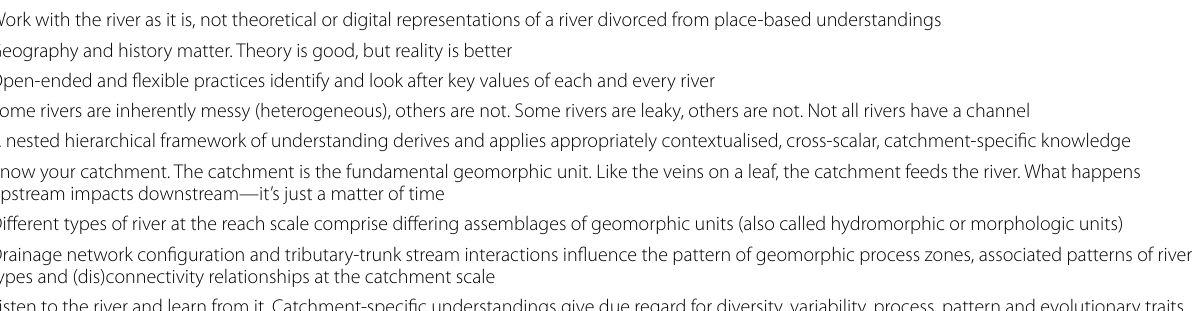
Table 3 Nested hierarchical (cross-scalar) approach to analysis of river systems (after Brierley and Fryirs 2005; Frissell et al. 1986; Gurnell et al. 2016; Naiman et al. 1992; Poff